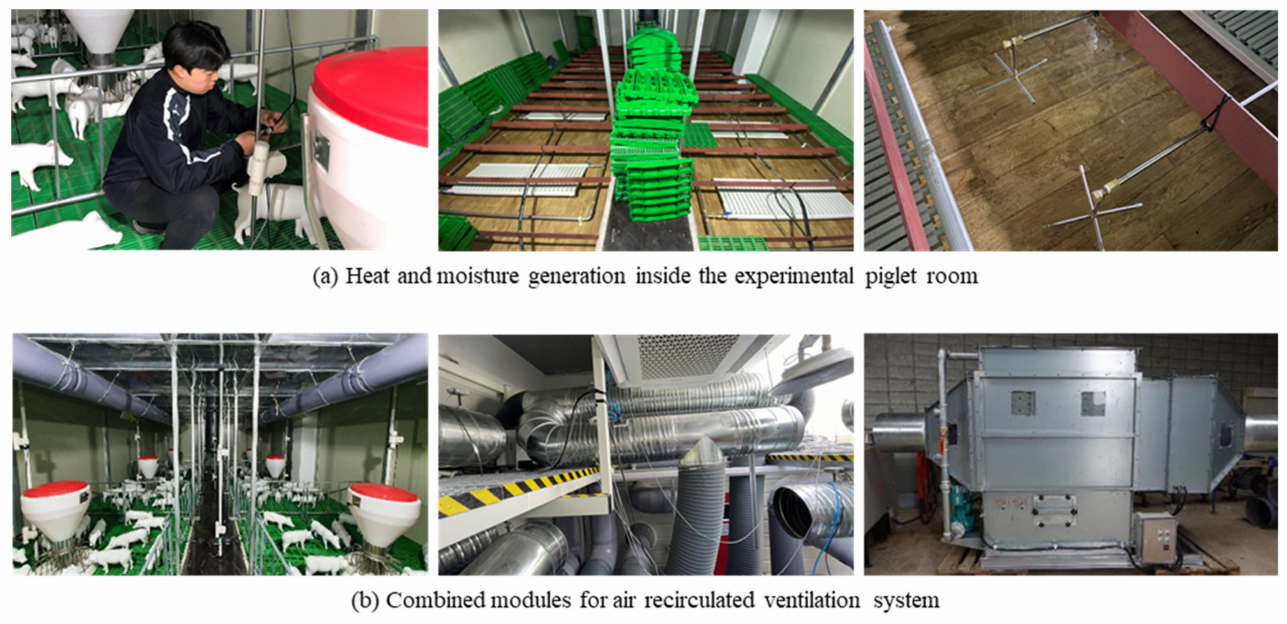
Figure 4. Measurement of air temperature for validation of the numerical design of